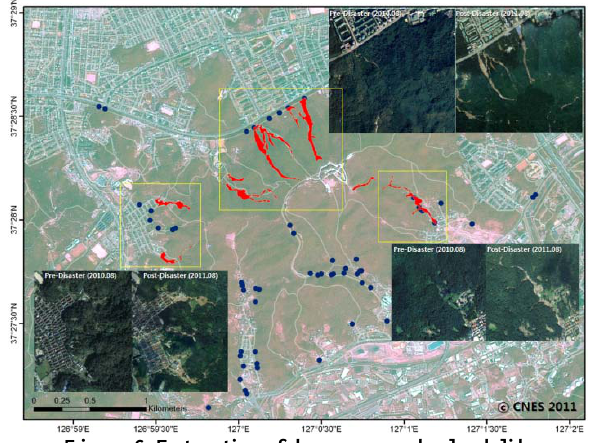
Figure 6. Extraction of damage area by landslide Aerial photos from the small manned helicopter and Unmanned Aerial Vehicle were conducted by post-processing procedure. For geometric correction and rectification of aerial images through an aerial triangulation (AT), Ground Control Points (GCPs) were extracted from 1/1,000 scale digital map produced at National Geographic Information Institute (NGII). After Aerial triangulation processing, the digital terrain model with 1m spatial resolution and 5cm-level ortho-rectified photos were generated. Final mosaicked ortho-imagery was made using DTM data and ten ortho-rectified photos with an accuracy of 1.45m (RMSE).